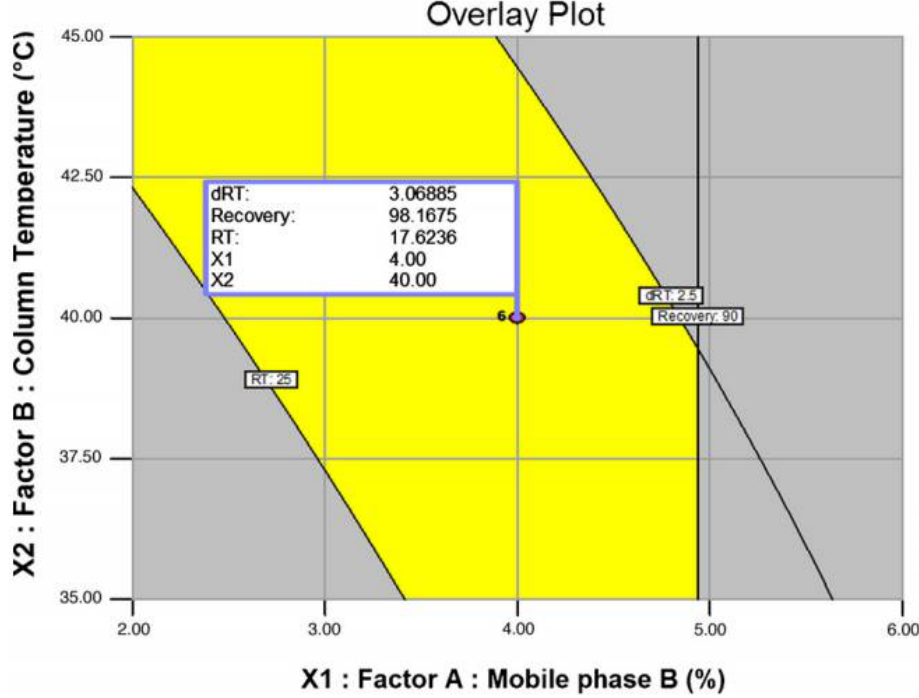
Figure 10: Overlay plot: an example used in the literature for the interpretation of a chromatographic design during the HPLC method development and optimization of multiple